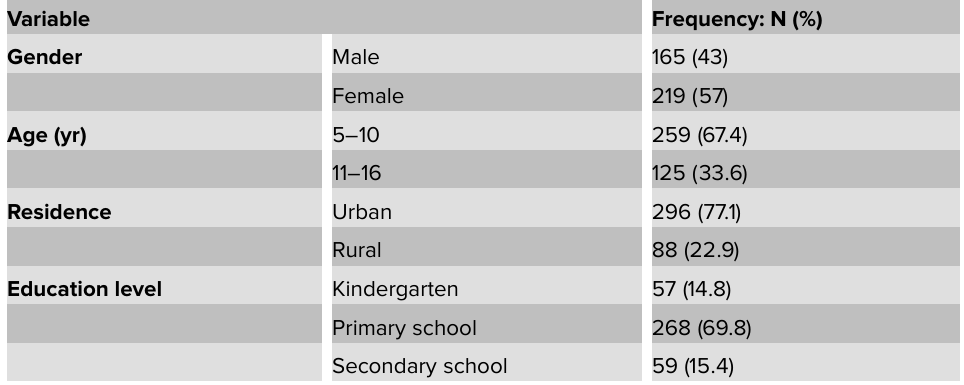
Table 1: Characteristics of the study